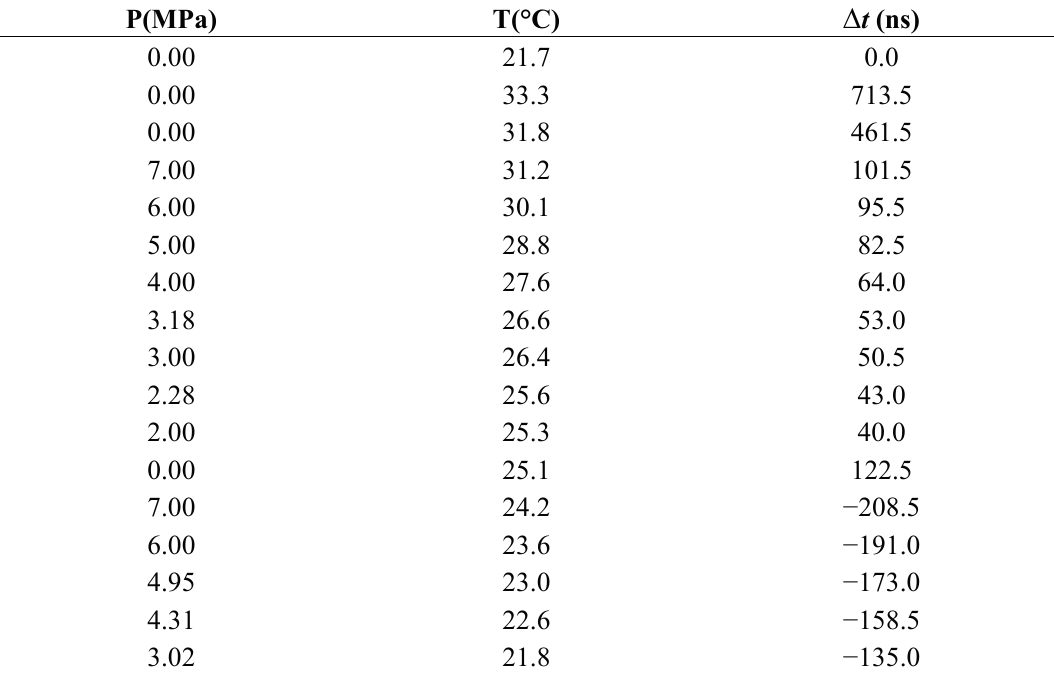
Table 2. Experimental results with different pressures and